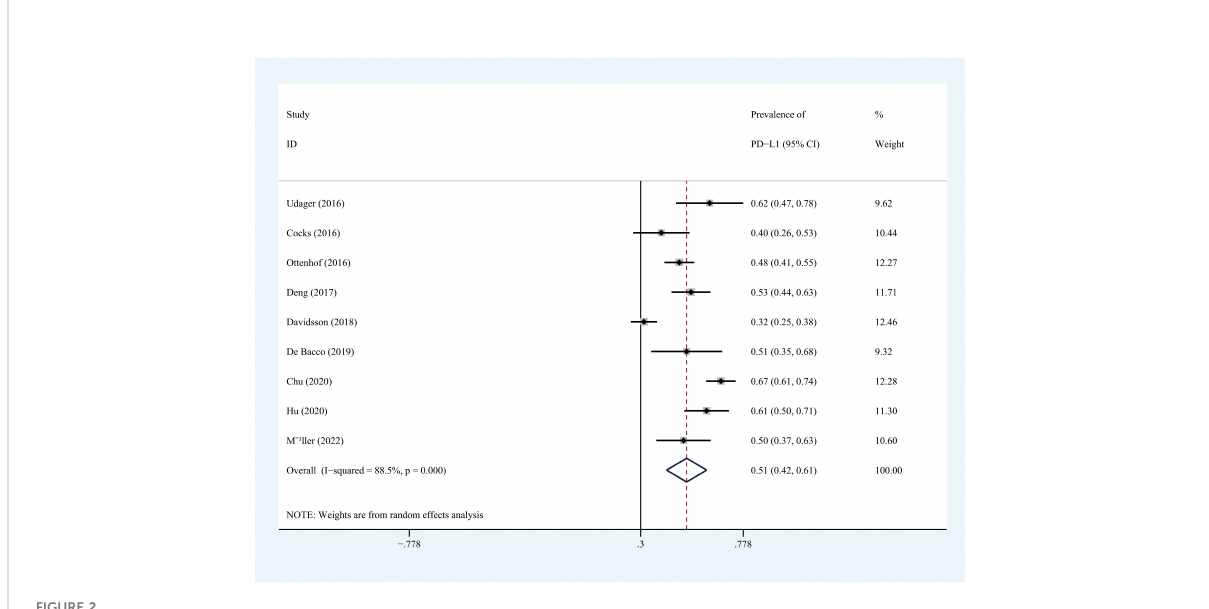
FIGURE 2 Prevalence of PD-L1 expression in penile cancer. CI, con fi dence